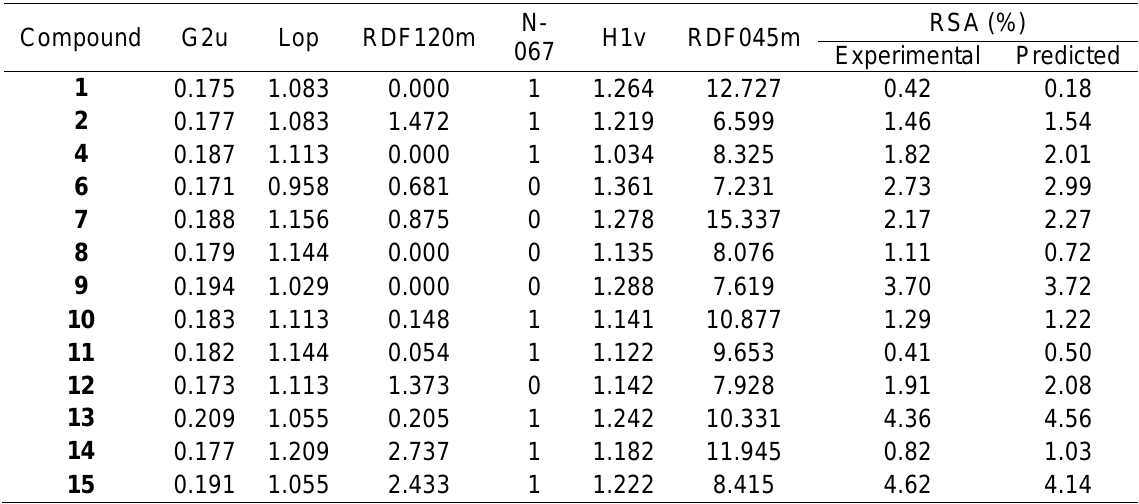
Table 4: Values of molecular descriptors and predicted RSA of sulfonamides Compound